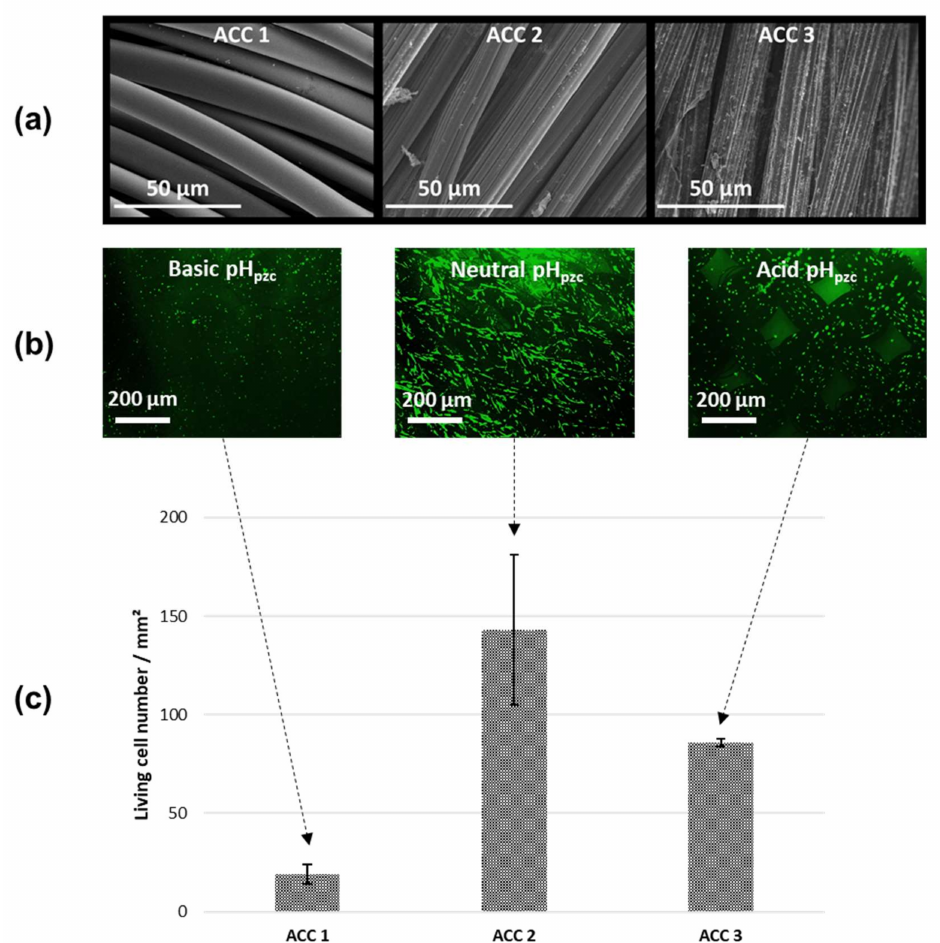
Figure 1. In vitro assessment after 2 days of culture of HOST cells on the three ACC materials. ( a ) SEM images of ACC 1, ACC 2 and ACC 3 substrates; ( b ) fluorescence microscopy images of living cells (green fluorescence) on basic, neutral and acid ACC surfaces; ( c ) living cell number per mm 2 on ACC surfaces obtained from the fluorescence